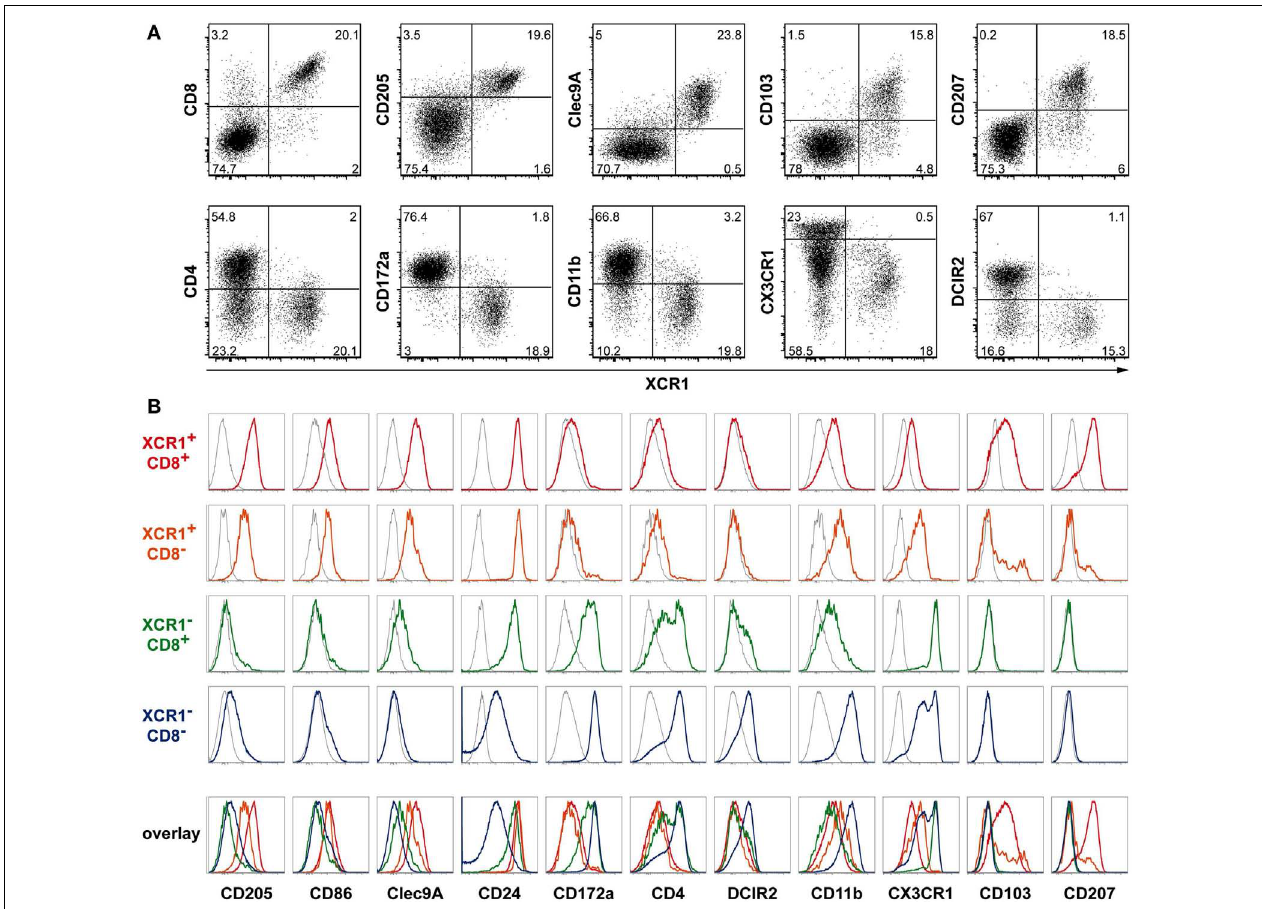
(A) Correlation and anti-correlation of XCR1 with the indicated surface molecules on splenic cDCs. Shown are results representative of three experiments. (B) Expression of the indicated surface markers on XCR1 + CD8 + (red), XCR1 + CD8 − (orange), XCR1 − CD8 + (green), and XCR1 − CD8 − (blue) splenic cDCs.The background staining was determined with isotype or FMO controls (gray).The data are representative of two or more